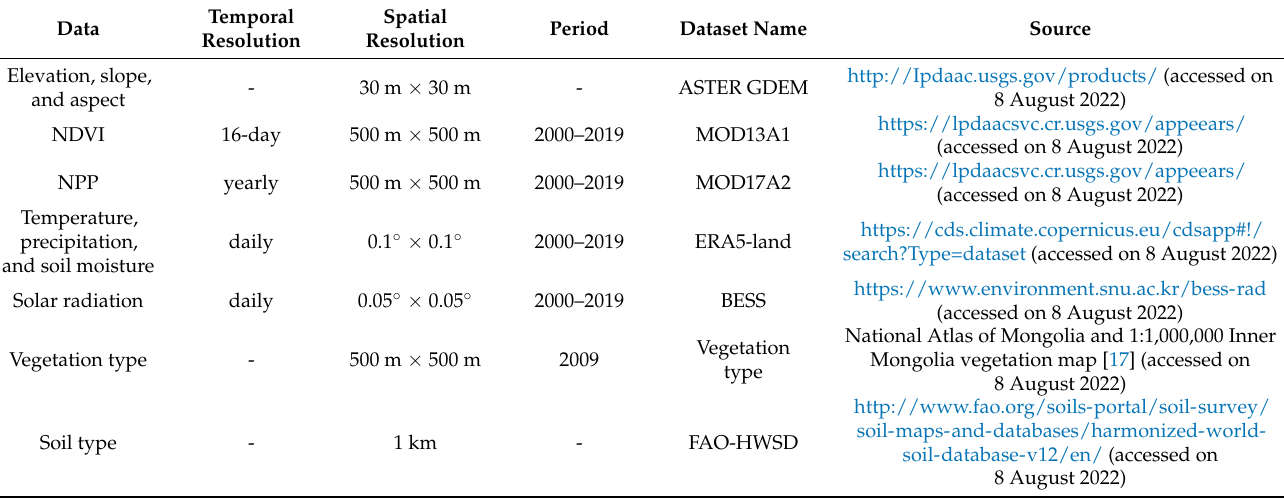
Table 1. List of datasets used for this study.